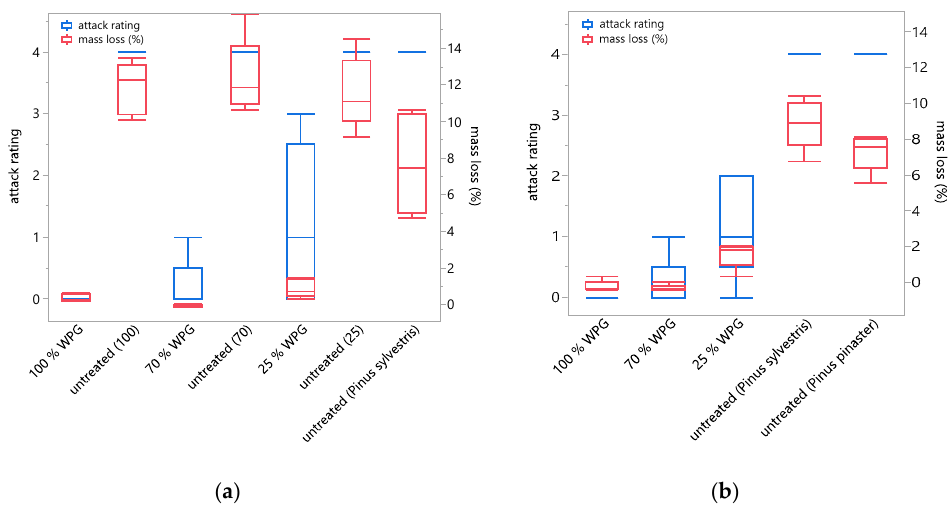
Figure 1. Mass loss (in red) and attack rating (in blue) of SCA-treated and untreated control wood after termite attack in ( a ) a two-choice test and ( b ) a no-choice test. A higher survival rate was observed in the no-choice test for untreated control P. pinaster compared with P. sylvestris , which was explained by a higher presence of mold and a higher final wood moisture content of P. sylvestris . However, the mass loss was slightly higher for P. sylvestris compared with P. pinaster . The high attack rating on untreated control wood samples in both setups validated the test.